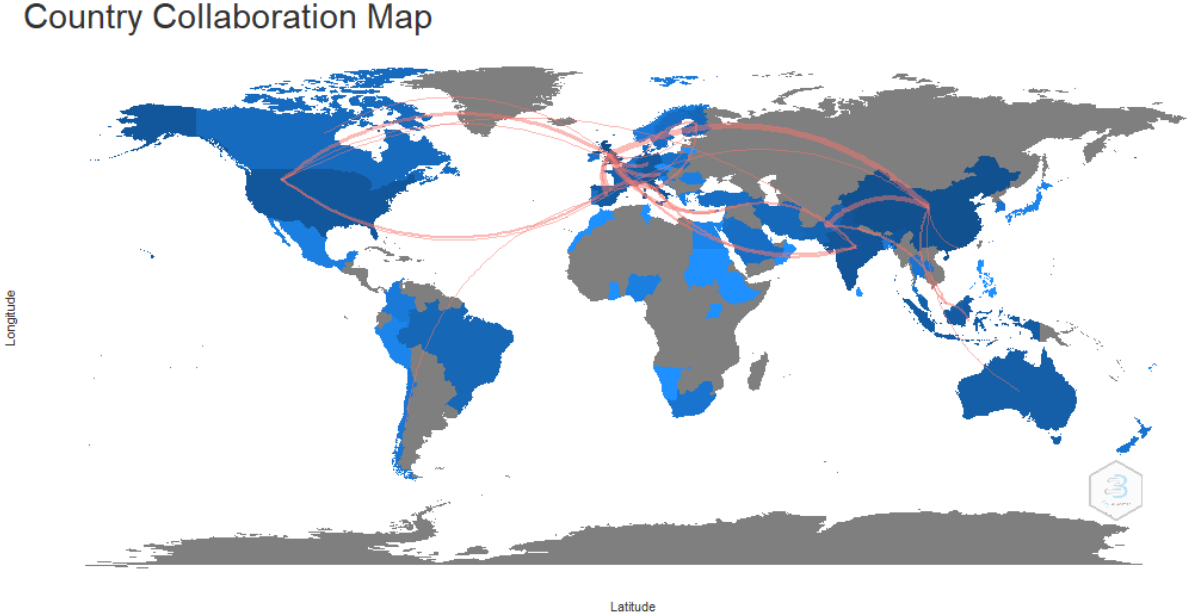
Figure 3. International research collaborations map on strategic ambidexterity and agility. Source: Scopus/Biblioshiny.